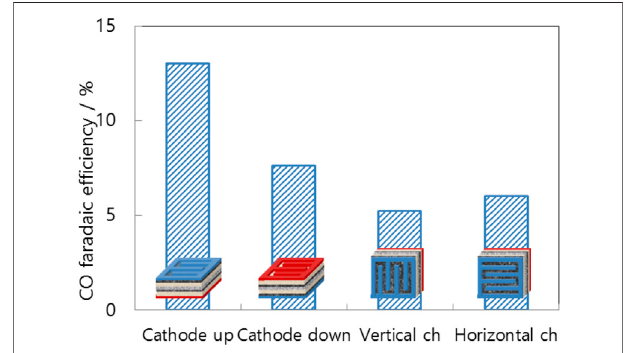
FIGURE 4 | CO faradaic ef fi ciency of differently positioned MEAs (cathode up/cathode down: supine cell with cathode face up/down, vertical channel/horizontalchannel:standingcellwithvertical/horizontalchannels)ata cell voltage of 3.0 V.